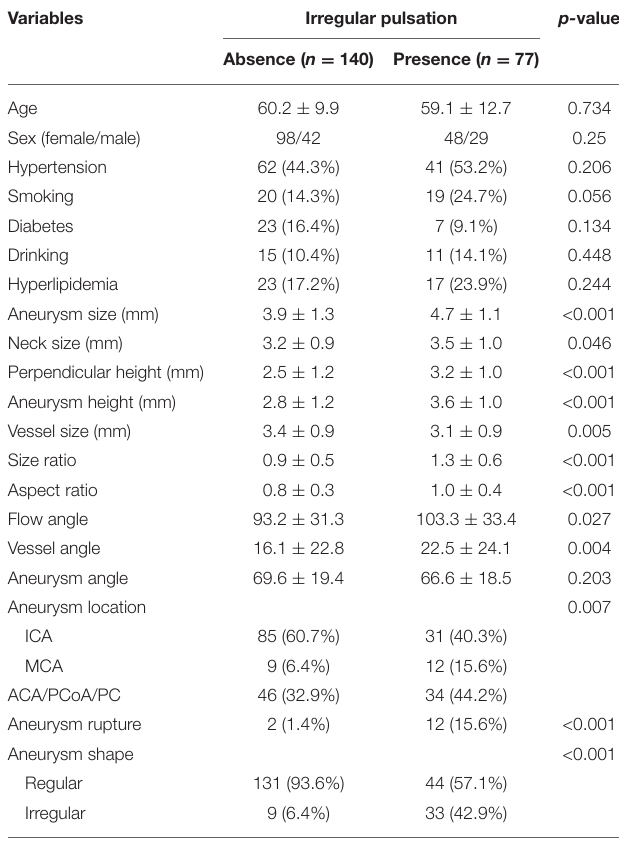
TABLE 3 | Baseline characteristics between aneurysms with irregular pulsation and those without irregular pulsation. Variables Irregular pulsation p-